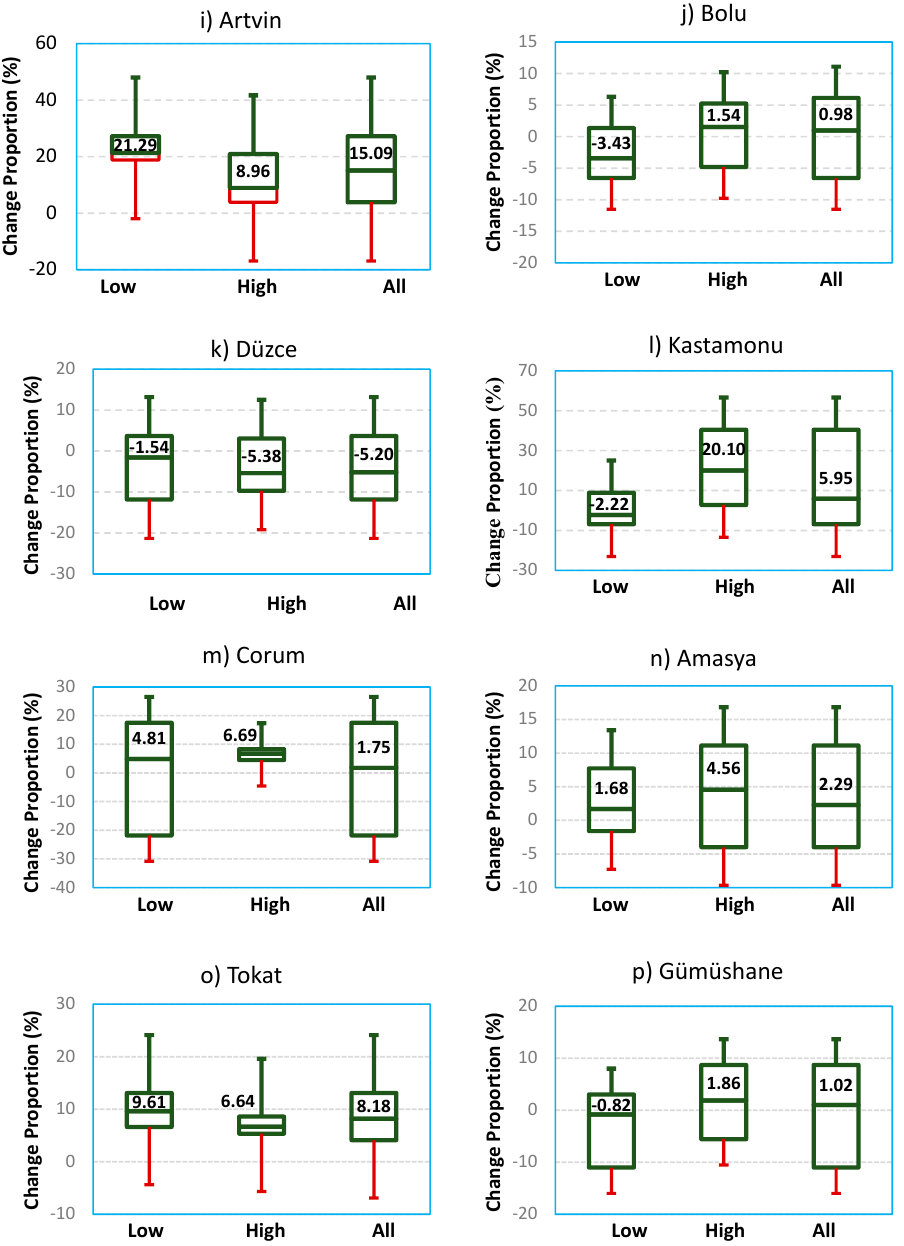
Figure 5. Annual trend graphs at the study stations using the ITA-CB.